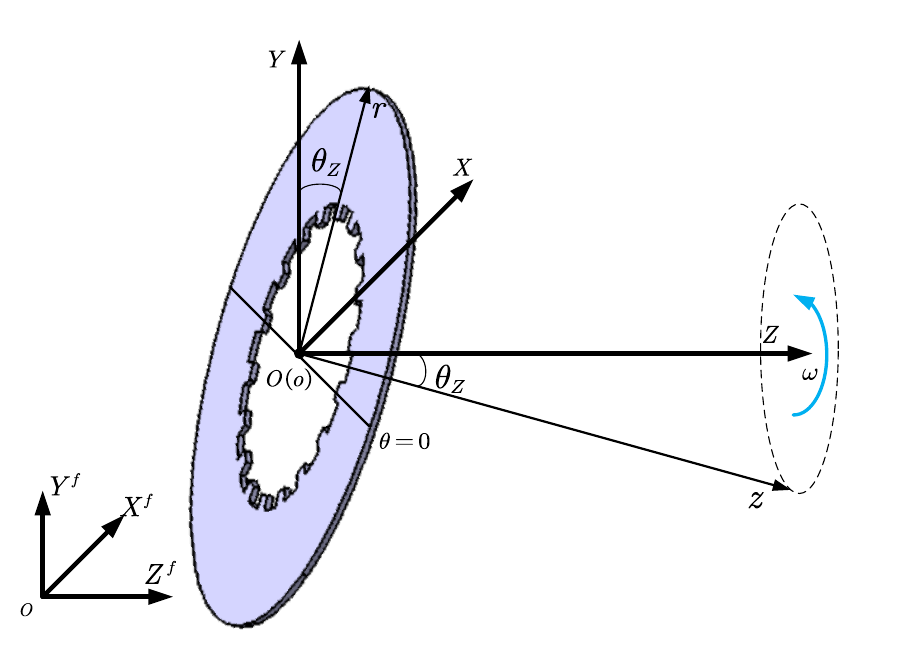
Figure 3. Coordinates of the spline-guided